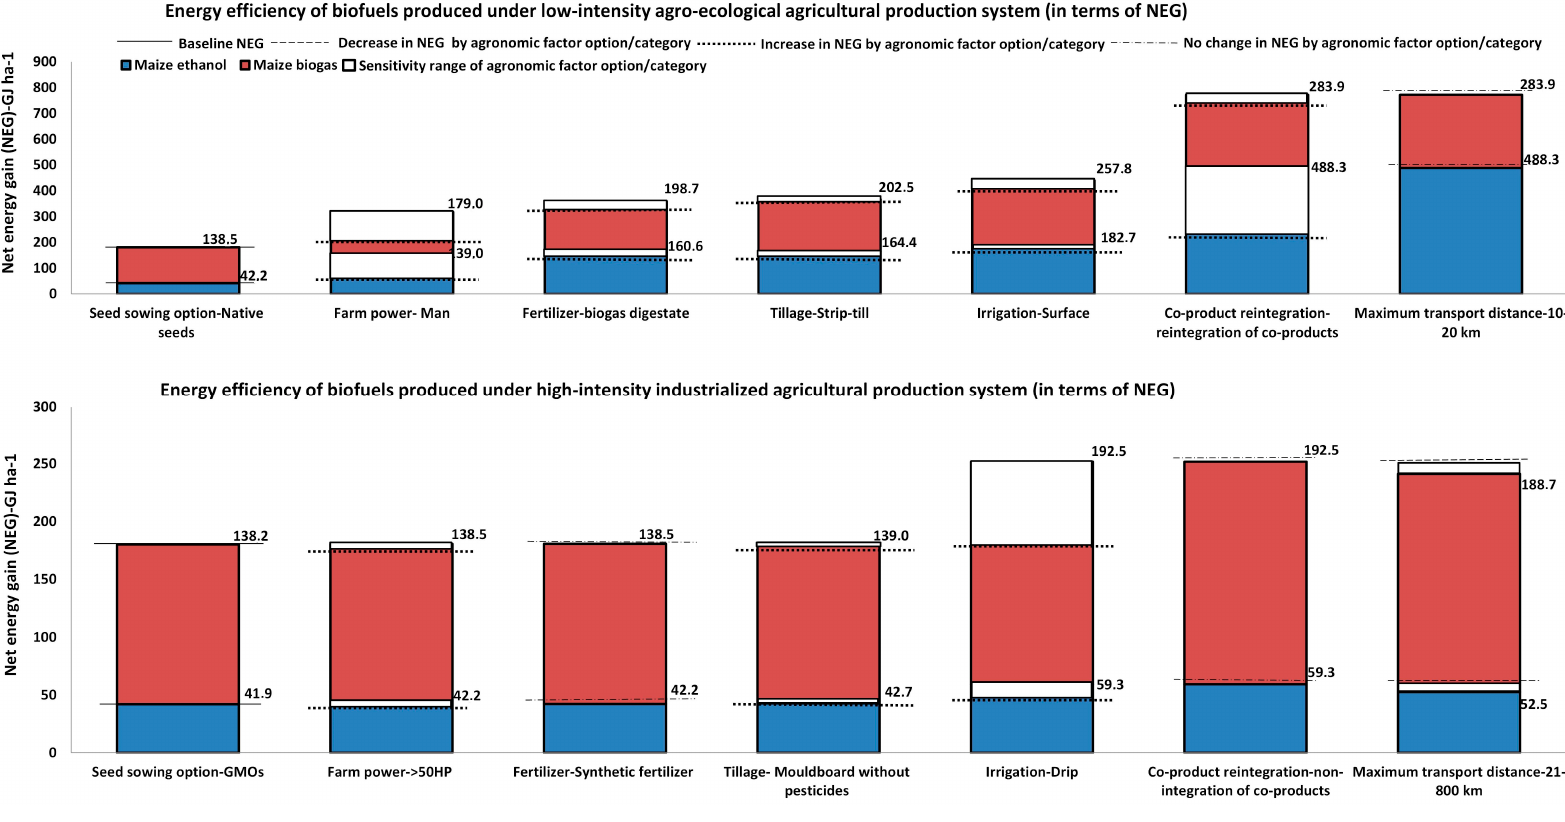
Figure 3. Comparison of the energy efficiency of biofuels produced under alternative agricultural production systems, i.e., high-intensity industrialized agricultural systems and low-intensity eco-agricultural production systems (in terms of NEG).